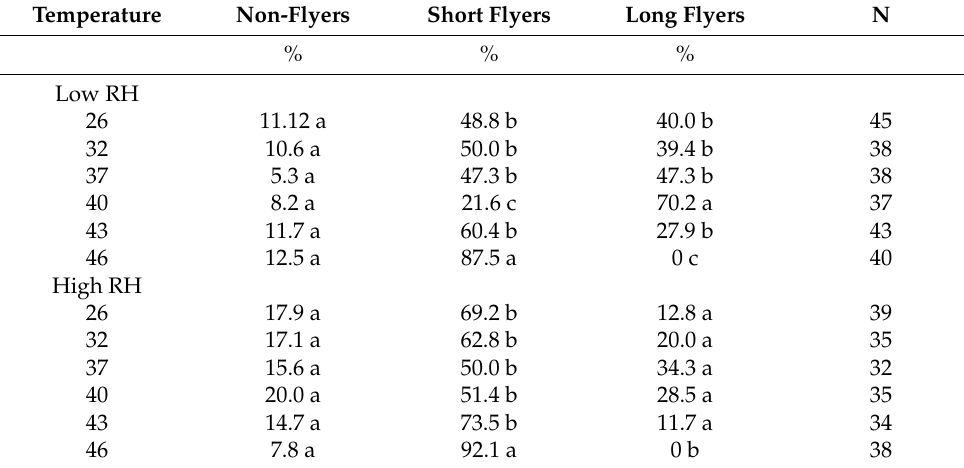
Table 1. Percentage of D. citri that did not engage in flight (non-flyers), engaged in flight for less than 60 s (short flyers), or engaged flights for more than 60 s (long flyers) when tested in a temperature- controlled flight mill under low or high relative humidity. Means followed by different letters within the same column are significantly different within each humidity category (Duncan χ 2 test p <